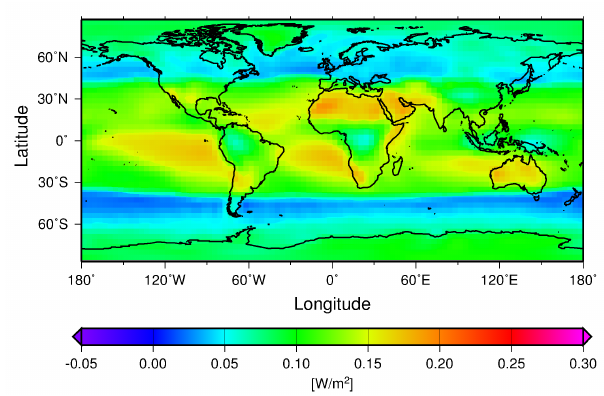
Fig. 11. Geographical distribution of the annual mean all-sky net radiative forcing at the top of the atmosphere for a homogeneous 1% contrail cover simulated with EMAC according to the bench- mark test by Myhre et al. (2009).